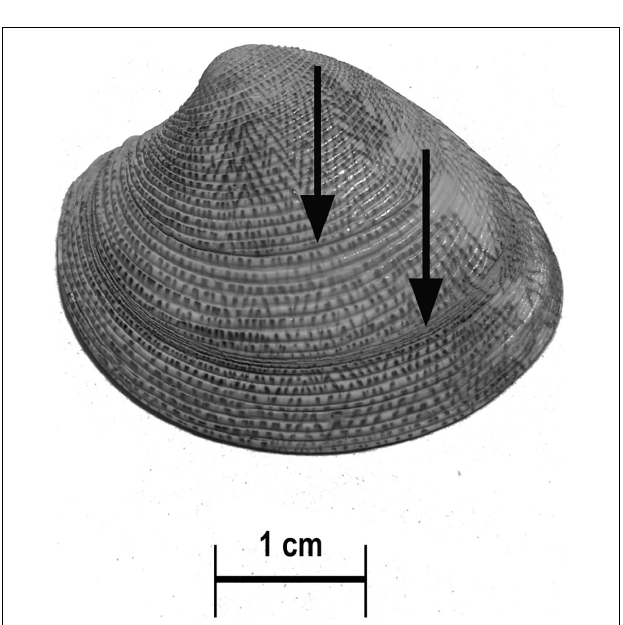
FIGURE 7 | Surface growth rings (arrows) on the shell of C. gallina aging 2 years old following this approach. The specimen measured 37.7 mm total length and was aged 6 years according to both the thin section and the acetate peel replica techniques.